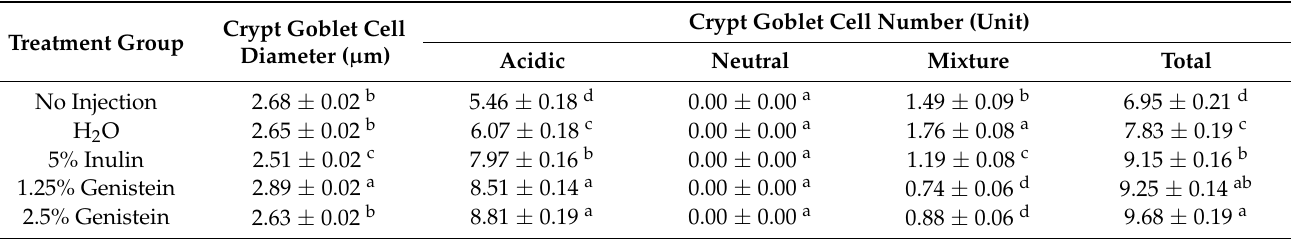
Table 6. Effects of genistein intraamniotic administration on crypt goblet cells 1 .